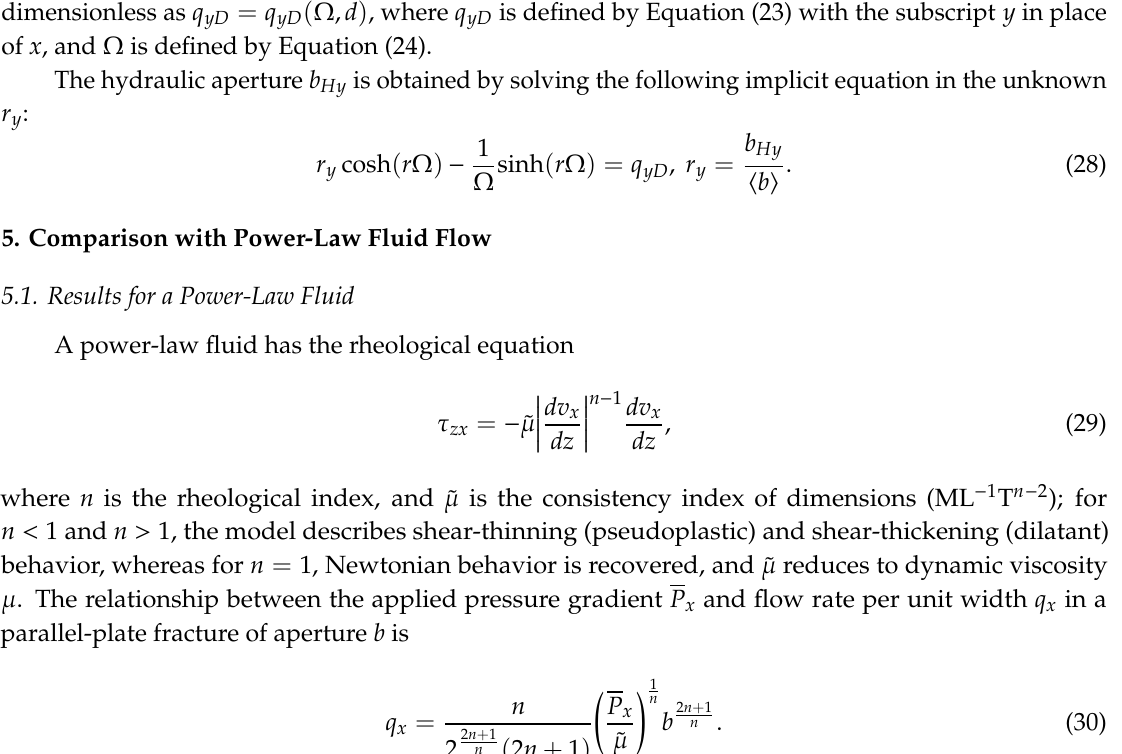
Figure 6. Ratio r x = b Hx / (cid:104) b (cid:105) versus dimensionless pressure gradient Ω for di ff erent values of the shape Figure 6. Ratio 𝑟 (cid:3051) = 𝑏 (cid:3009)(cid:3051) 〈𝑏〉⁄ versus dimensionless pressure gradient Ω for different values of the